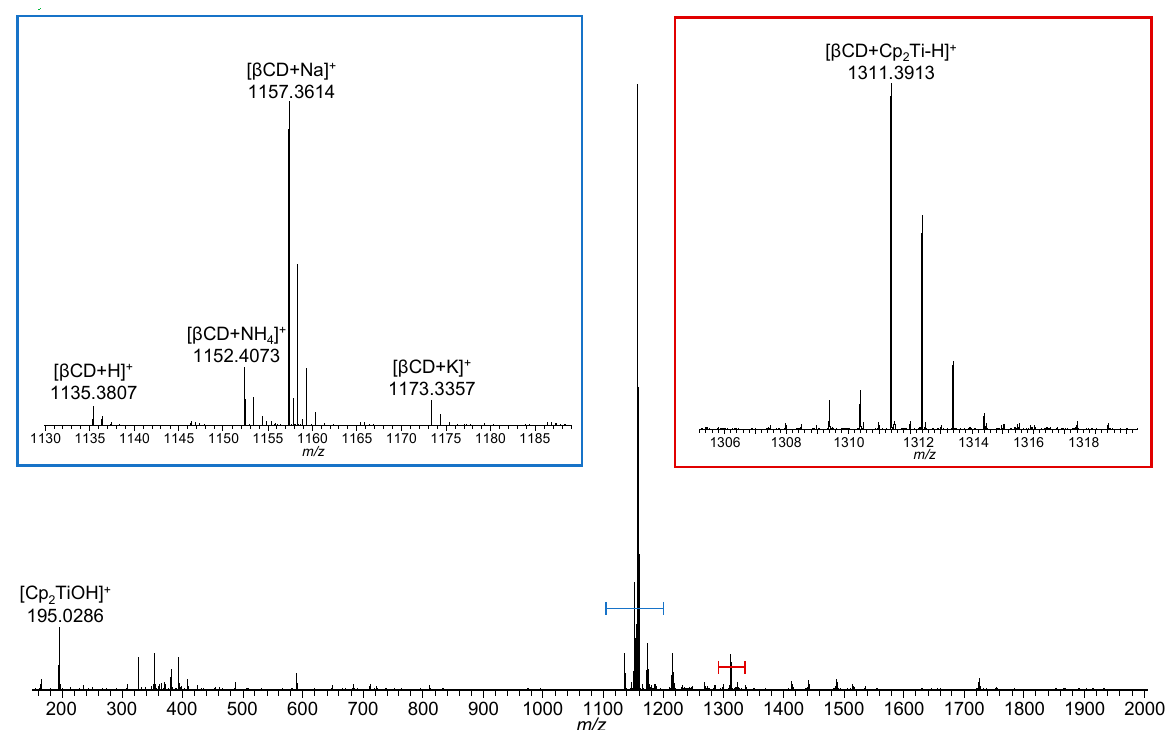
Figure 4. Full scan mass spectrum of the mixture of β -cyclodextrin and titanocene dichloride showing the peak indicating an interaction between the two compounds (red inset), as well as the hydrolyzed titanocene, and cationized β -cyclodextrin (blue).